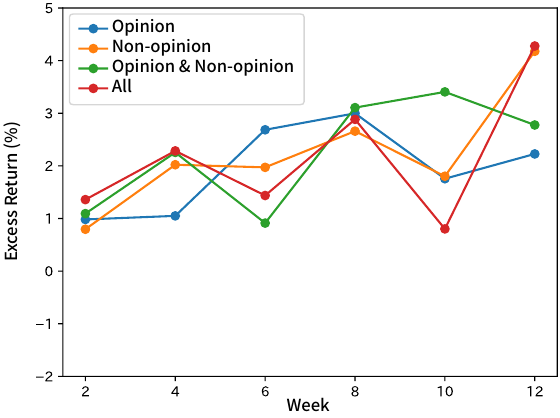
Figure 10. Excess returns of Broker B in forecasting excess returns.